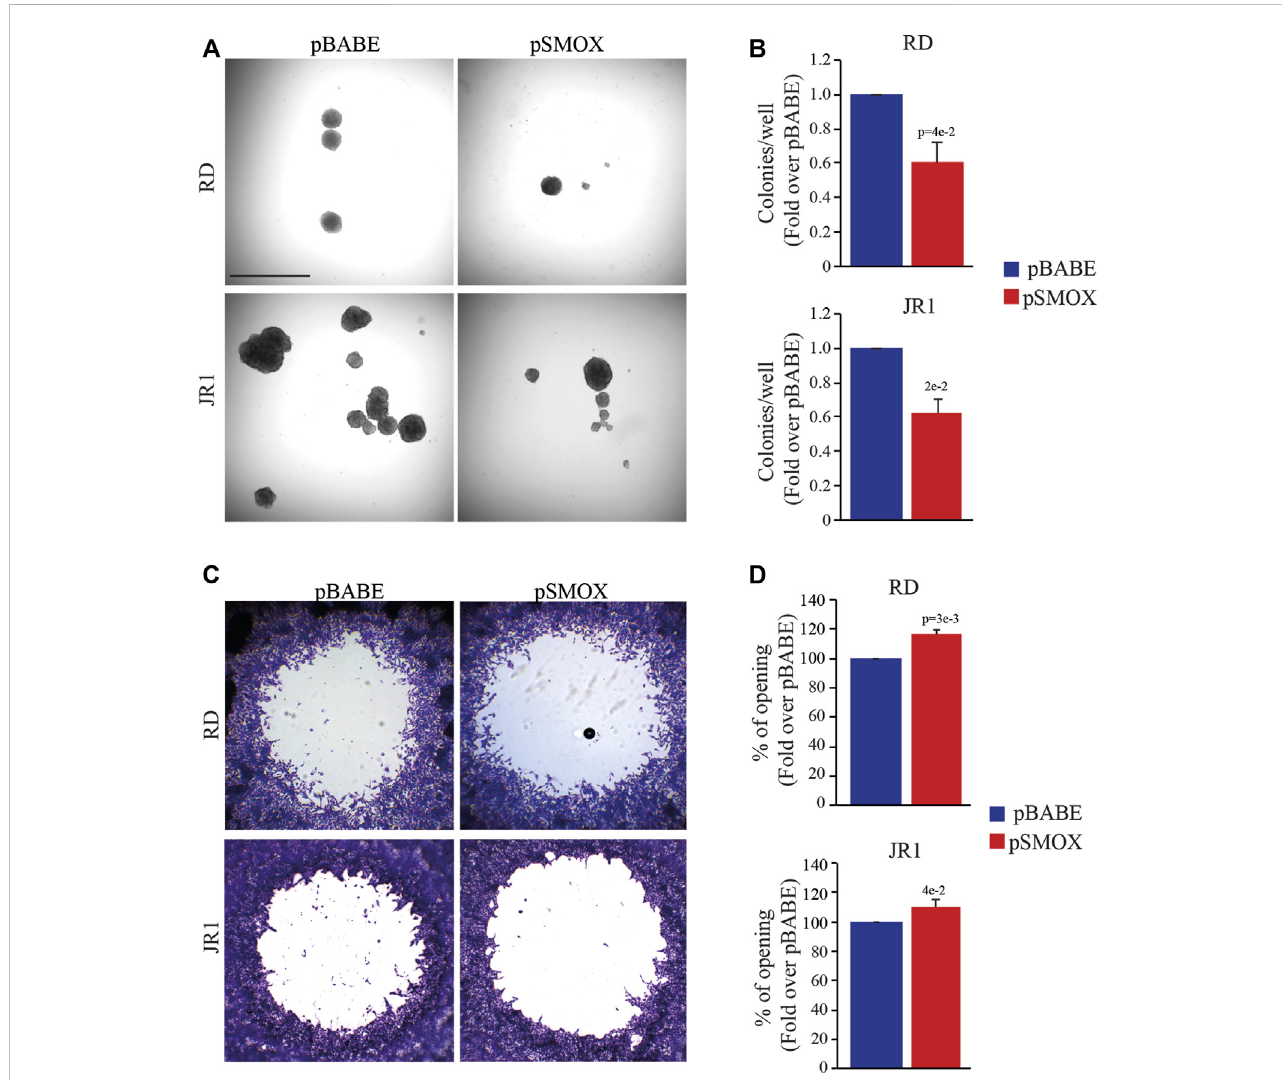
FIGURE 4 SMOX overexpression affects the in vitro tumorigenic features of FN-RMS cells. (A) Representative light microscopy images of soft agar assay of RD and JR1 cells transduced with either pBABE or pSMOX. Scale Bar = 100 μ m. (B) Histogram of colony number quanti fi cation ( n = 3 biologically independent experiments). Colonies were counted 14 days after seeding. Graphs represent the mean of three independent experiments ±SD, Student two-tailed t -Test. Exact p -values are reported in the fi gure. (C) Representative phase contrast microscopy images of the migration assays at 24 h after detection zone creation in RD and JR1 cells. (D) The histograms depict the measurements of the detection zone of pSMOX, expressed as fold change over control pBABE. Graphs represent the mean of three independent experiments ±SD, Student two-tailed t -Test. Exact p -values are reported in the fi